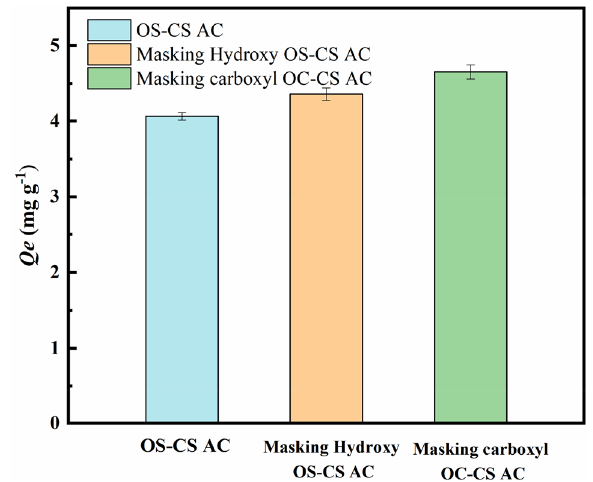
Figure 10. Hydroxyl and carboxyl masking experiment.